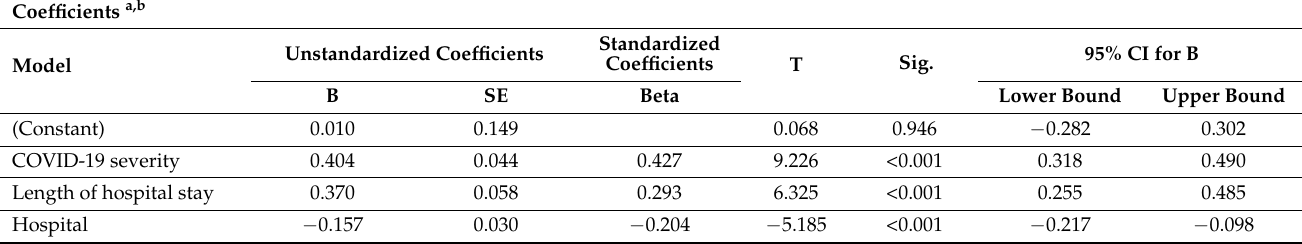
Table 6. Factors associated with antibiotic use in children with